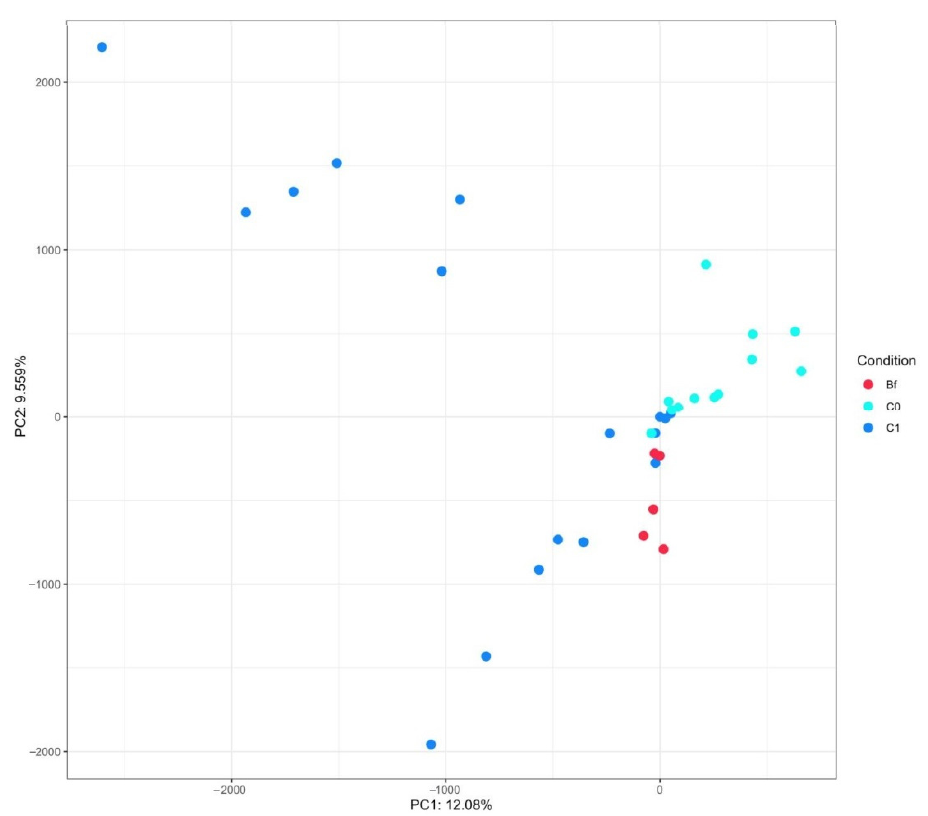
Figure 6. Principal component analysis fecal samples’ metagenome of rats from different groups.